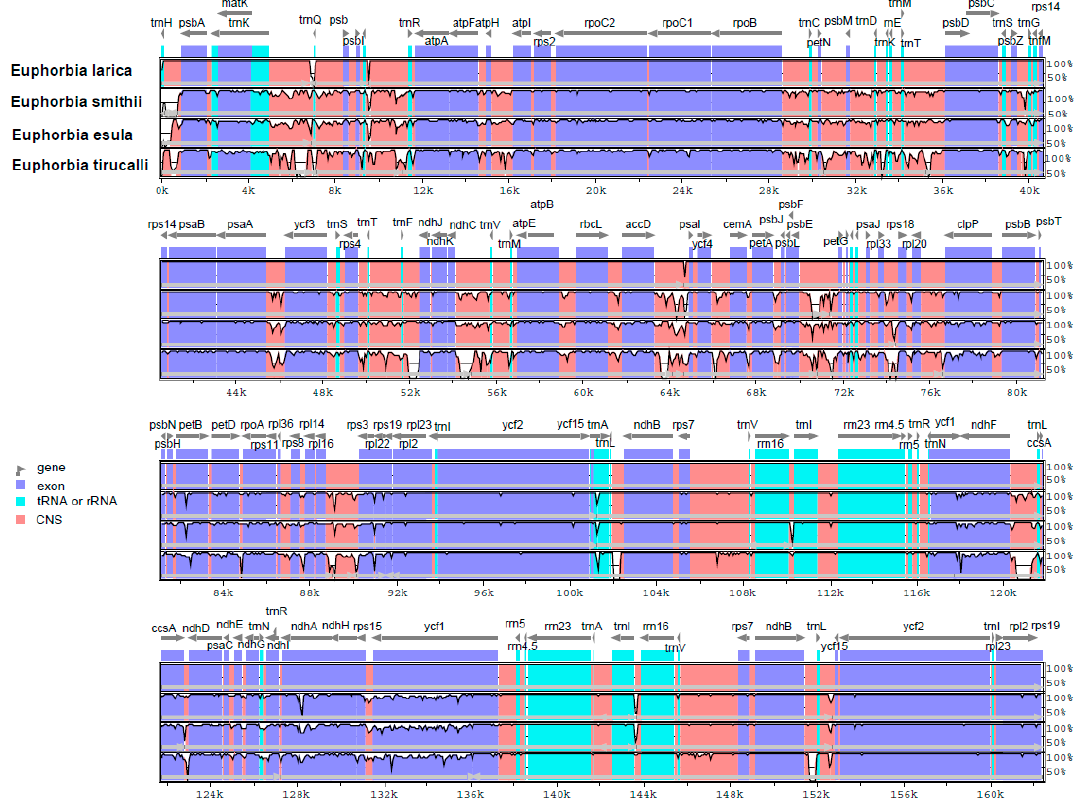
Figure 5. Visual alignment of plastid genomes with the previously reported cp genomes. VISTA-based identity plot showing sequence identities among eight species, using E. larica as a reference.